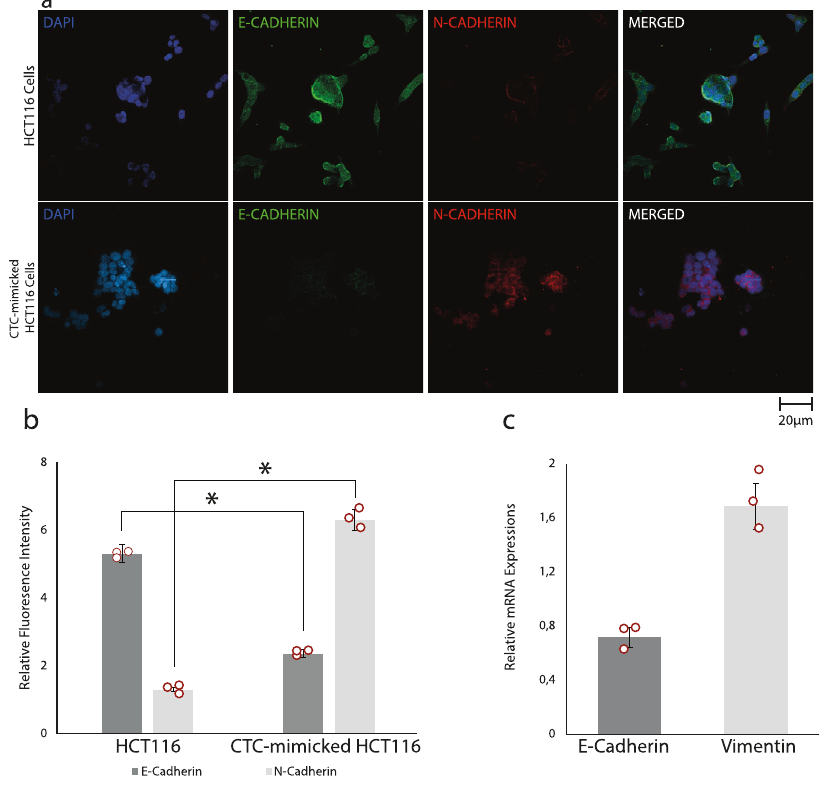
c E-cadherinandvimentinmRNAexpressionrelativetohousekeepinggene GAPDH by 2 (cid:1) ΔΔ Ct value calculation. E-cadherin expression was decreased 0.7-times and vimentinexpressionwasincreased1.7-timesafterTGF- β treatmentfor48h.Alldata in b and c are expressed as mean±S.D. (standard deviation) for data collected in n =3 over three independent experiments and star (*) indicates p <0.05